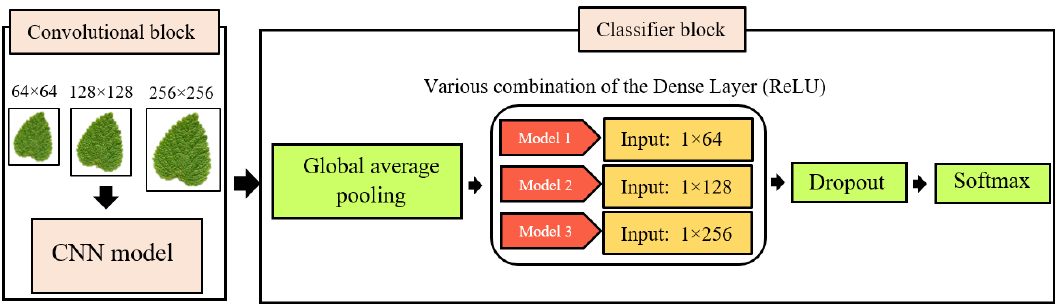
Figure 7. A summary of the proposed model for the identification of medicinal plant species.